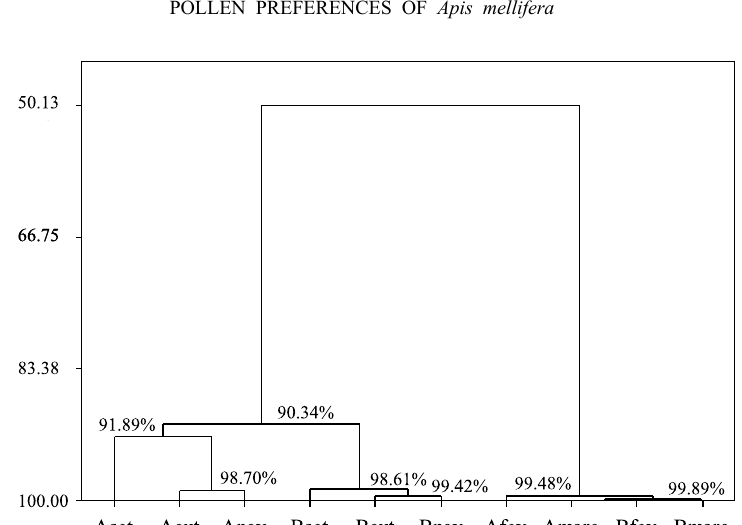
Fig. 2 – Percentage similarity dendrogram carried out on pollen data per month from beehive A (Aset, Aout, Anov, Afev and Amarc) and B (Bset, Bout, Bnov, Bfev and Bmarc), Pará de Minas, Minas Gerais